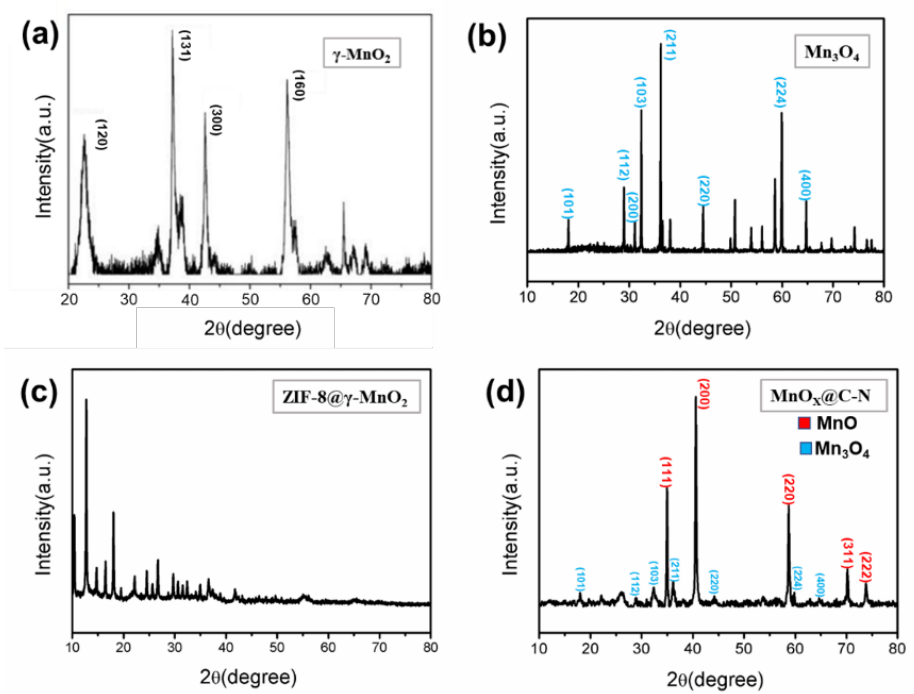
Figure 2. XRD patterns of ( a ) γ -MnO 2 ; ( b ) γ -MnO 2 heated under 800 ◦ C; ( c ) ZIF-8@ γ -MnO 2 ; and ( d ) MnO x @C-N.